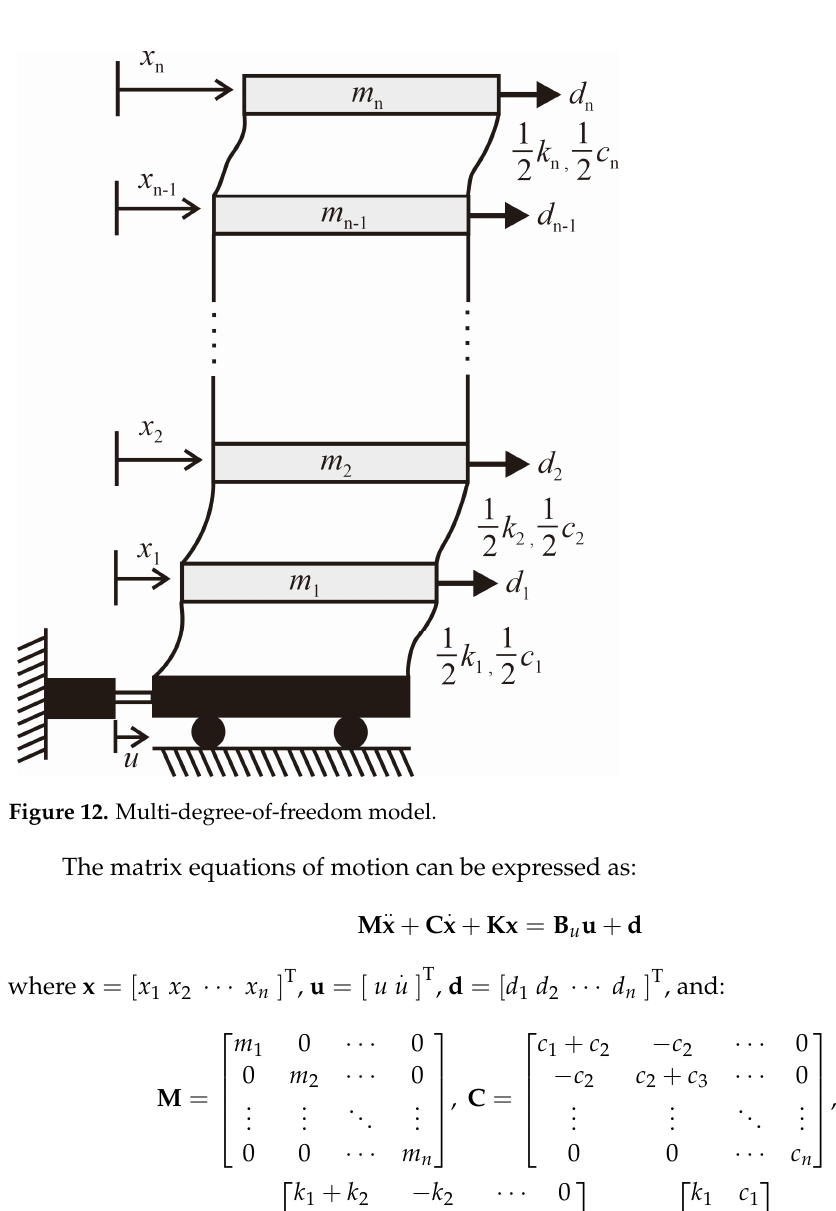
Figure 11. Free vibration response when the controller is turned on in the middle of the time.